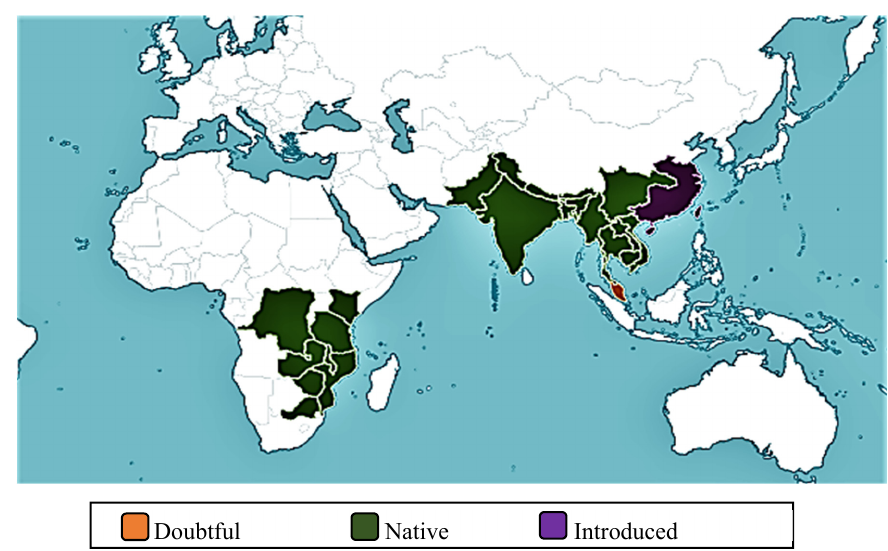
Figure 1. Worldwide distribution of H. pubescens [3].